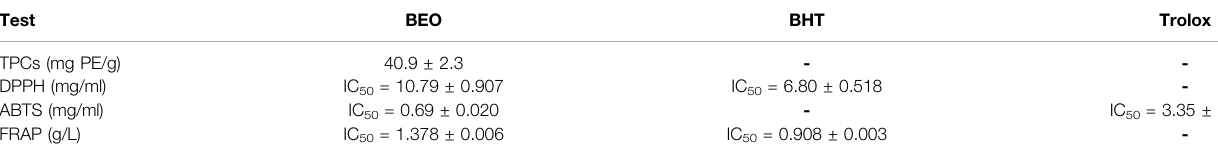
TABLE 3 | Phytochemical analysis of BEO.